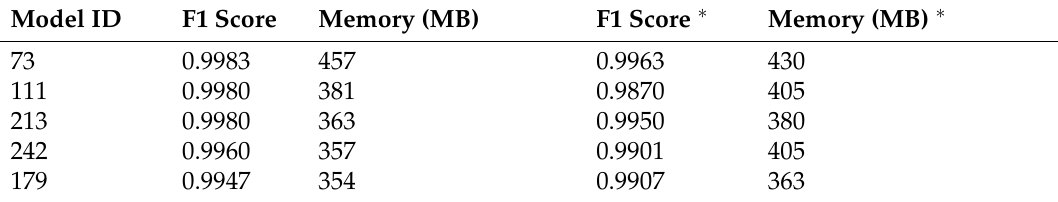
Table 2. Models on the wall clock Pareto front (columns with ∗ report results for new test set).